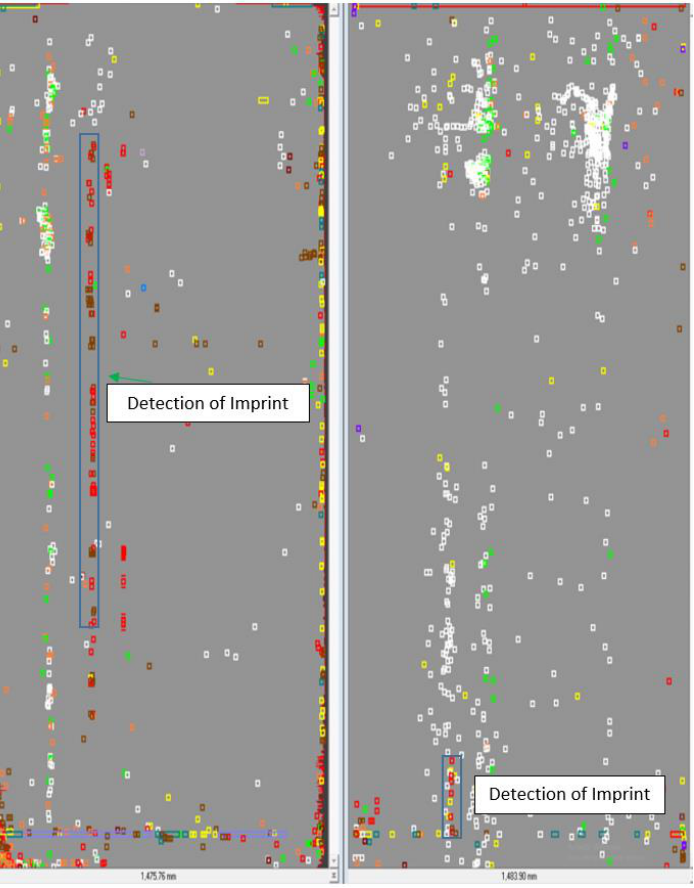
Figure 16. Surface defect distribution Pickling line (processed in Ametek camera), [31]. Left: strip bottom right: strip top.